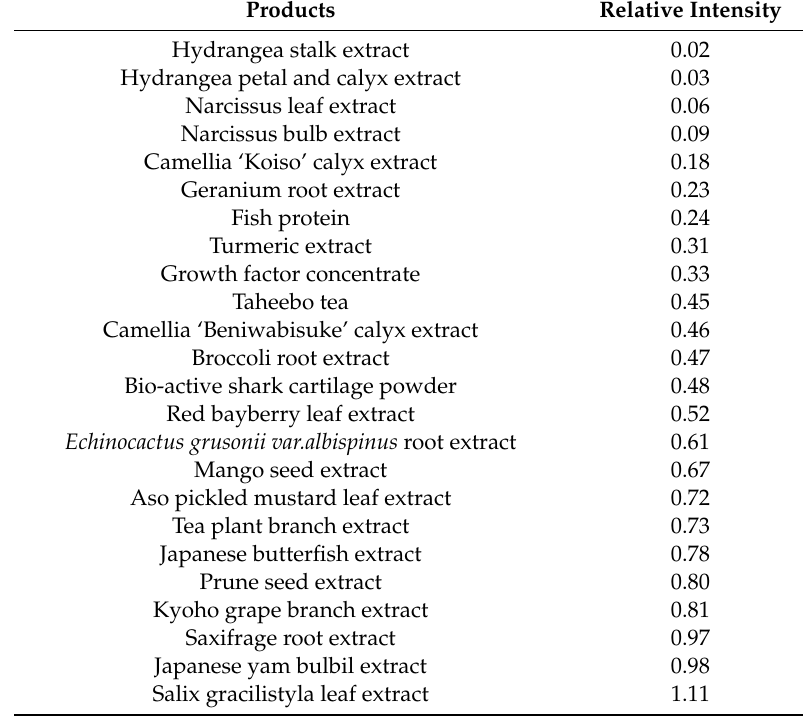
Table A2. Secondary screening for natural product HIF inhibitors with statistical analysis compared with CoCl 2 -administrated controls ( n = 3). * Positive control